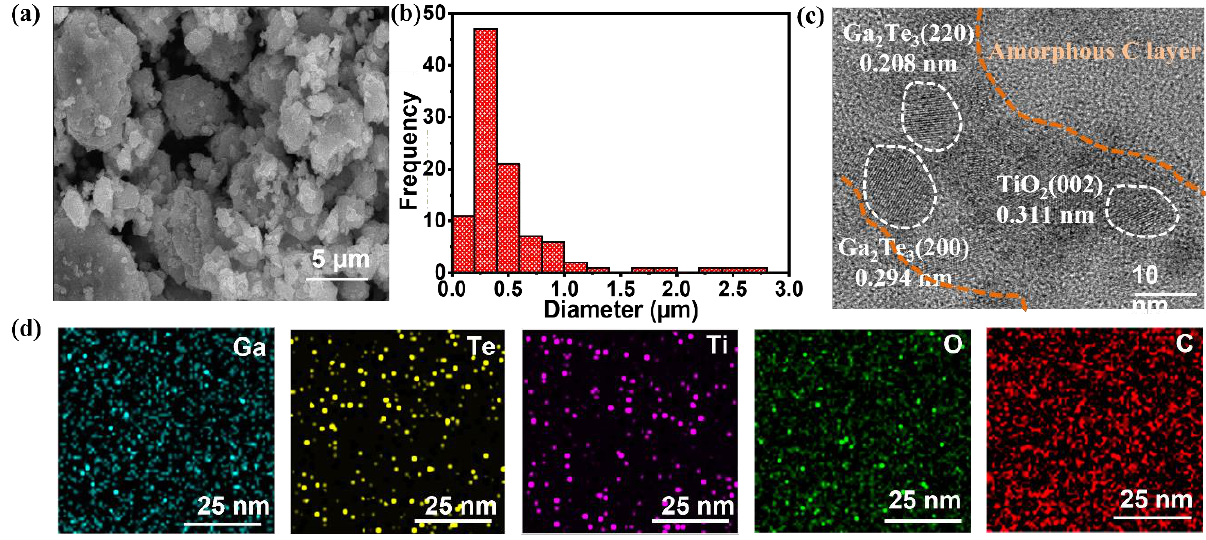
Figure 2. ( a ) SEM image; ( b ) size distribution; ( c ) HRTEM image; ( d ) EDXS elemental mappings of Ga, Te, Ti, O, and C in Ga 2 Te 3 – TiO 2 – C(10%).